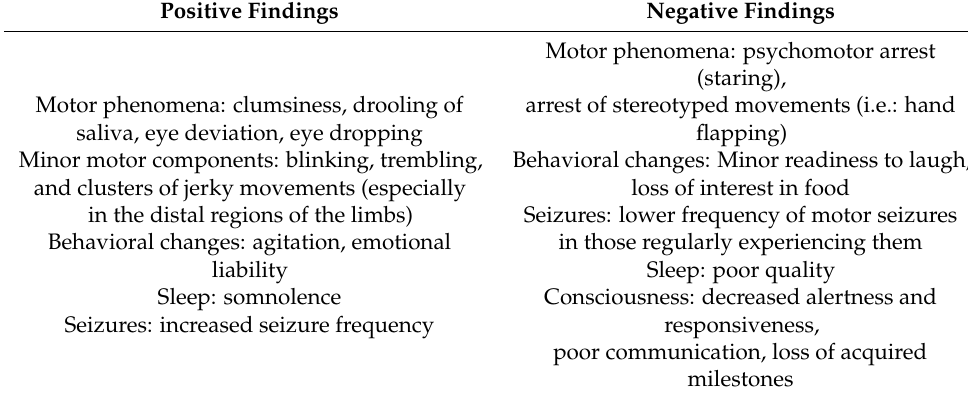
Table 3. Clinical features of Non-Convulsive Status Epilepticus in patients with Angelman Syndrome. Positive